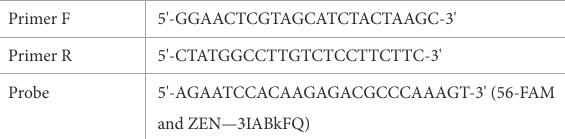
TABLE 2 Lacticaseibacillus paracasei 8700:2 strain specific primer and probe sequences. Primer